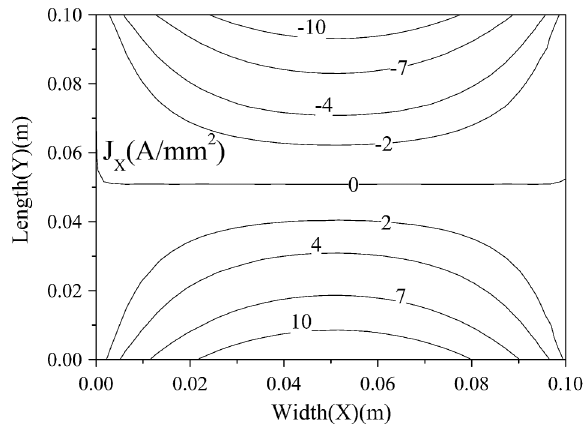
FIG. 2. The 3D model used for simulation study is shown here. Different colors represent the vertical component of the field B (from (cid:3) 1 : 431 052 T to 1.761 941 T) in the magnet core and z the plate.